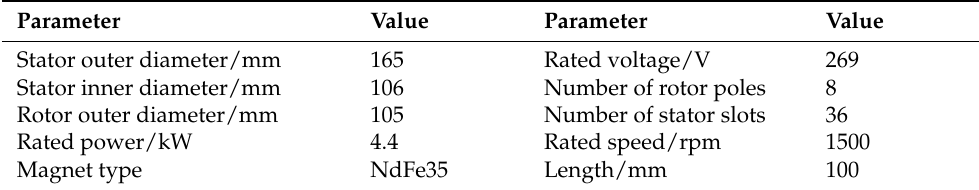
Table 1. Basic parameters of SPMSM.